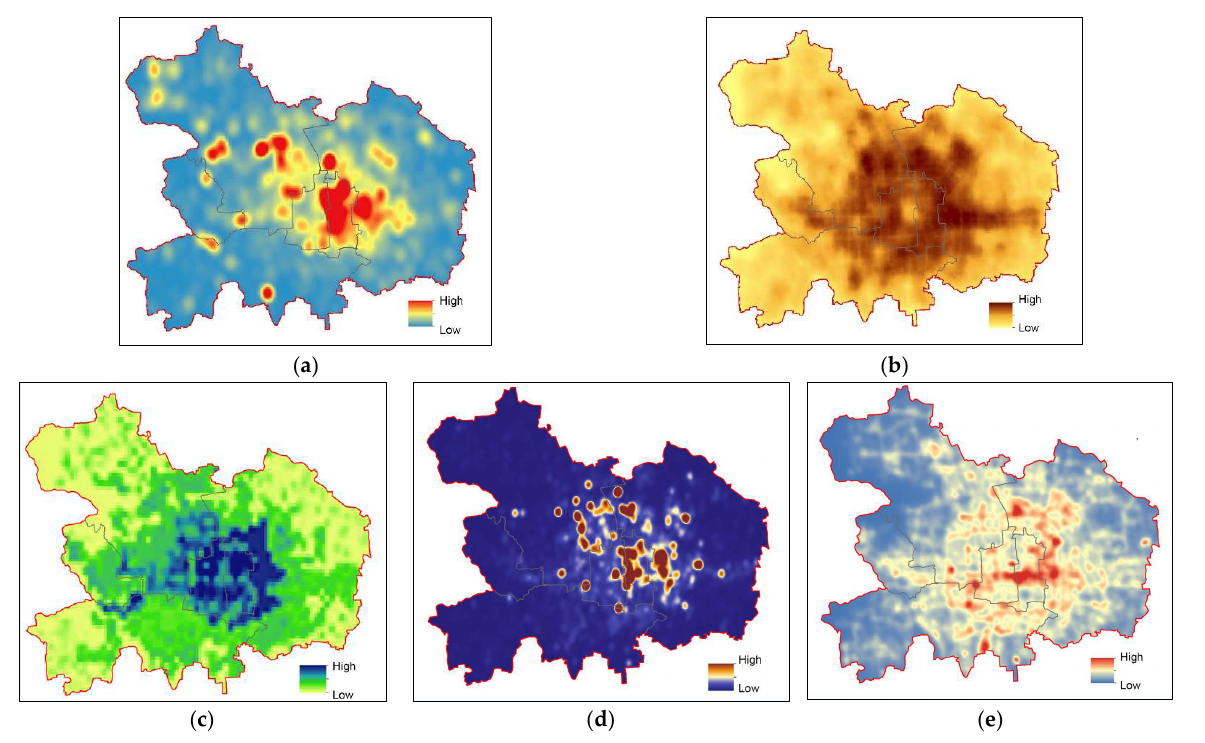
Figure 5. Evaluation results of various recreational services factors in the study area: ( a ) assessment of distribution of key recreation resources; ( b ) assessment of accessibility to recreational resources; ( c ) assessment of the recreation demand potential—population aggregation; ( d ) assessment of the recreation demand potential—economic development potential; ( e ) assessment of the recreation de- mand potential—user‘s tendency.